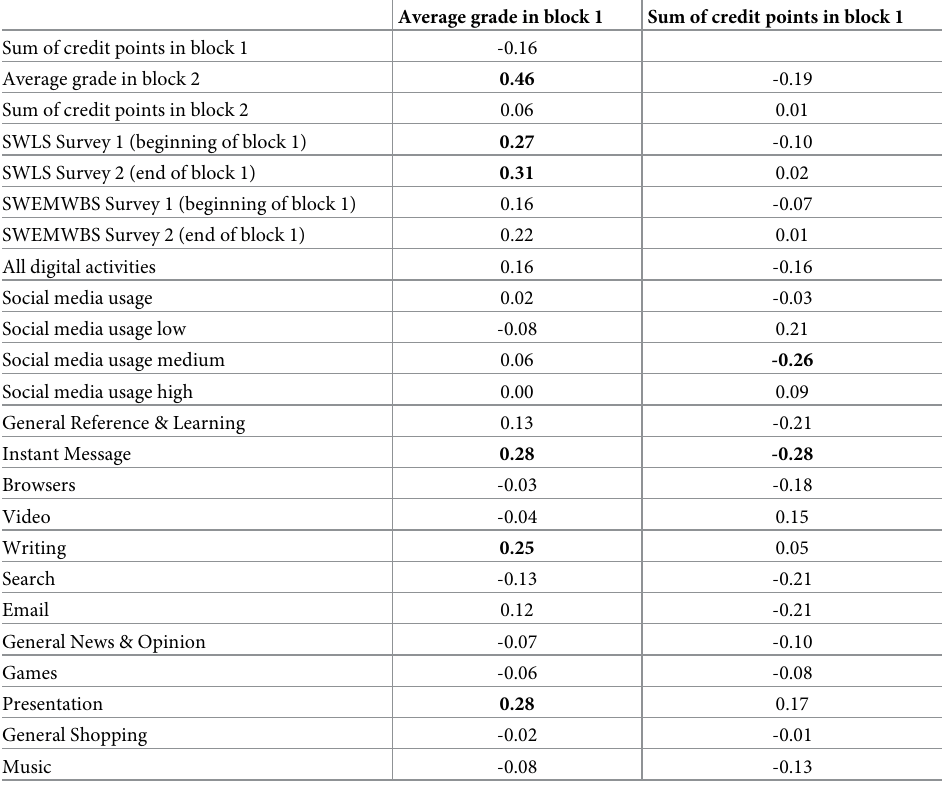
Table 5. Correlations of academic performance with measures of subjective well-being and digital activities in block 1 (Android